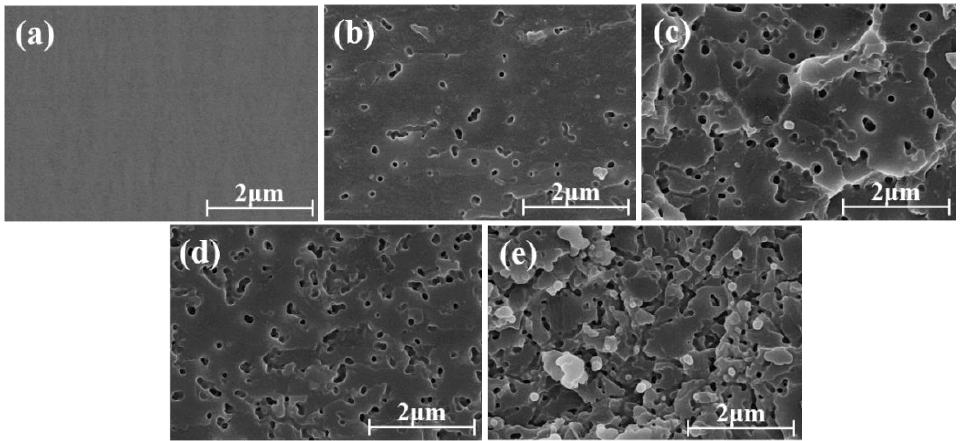
Figure 11. SEM micrographs of the fractured surfaces of PSF/epoxy blends etched with THF; ( a ) 0 phr, ( b ) 5 phr, ( c ) 10 phr, ( d ) 15 phr, ( e ) 20 phr.